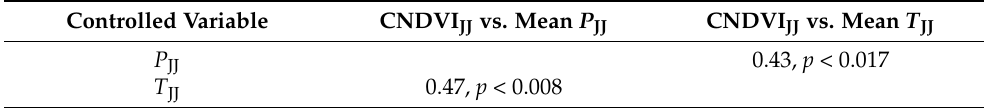
Table 3. Partial correlation between the CW–DHM region CNDVI JJ and precipitation (P JJ ) and temperature (T JJ ) from CRU TS 4.01 (1982–2013 CE).